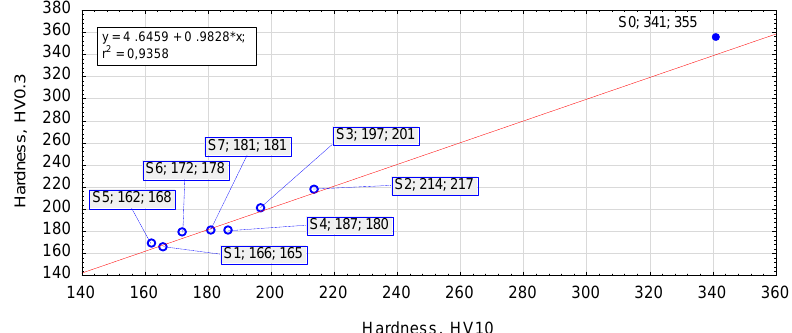
Figure 8. Hardness of as-received (S0) and annealed (S1–S7) samples.